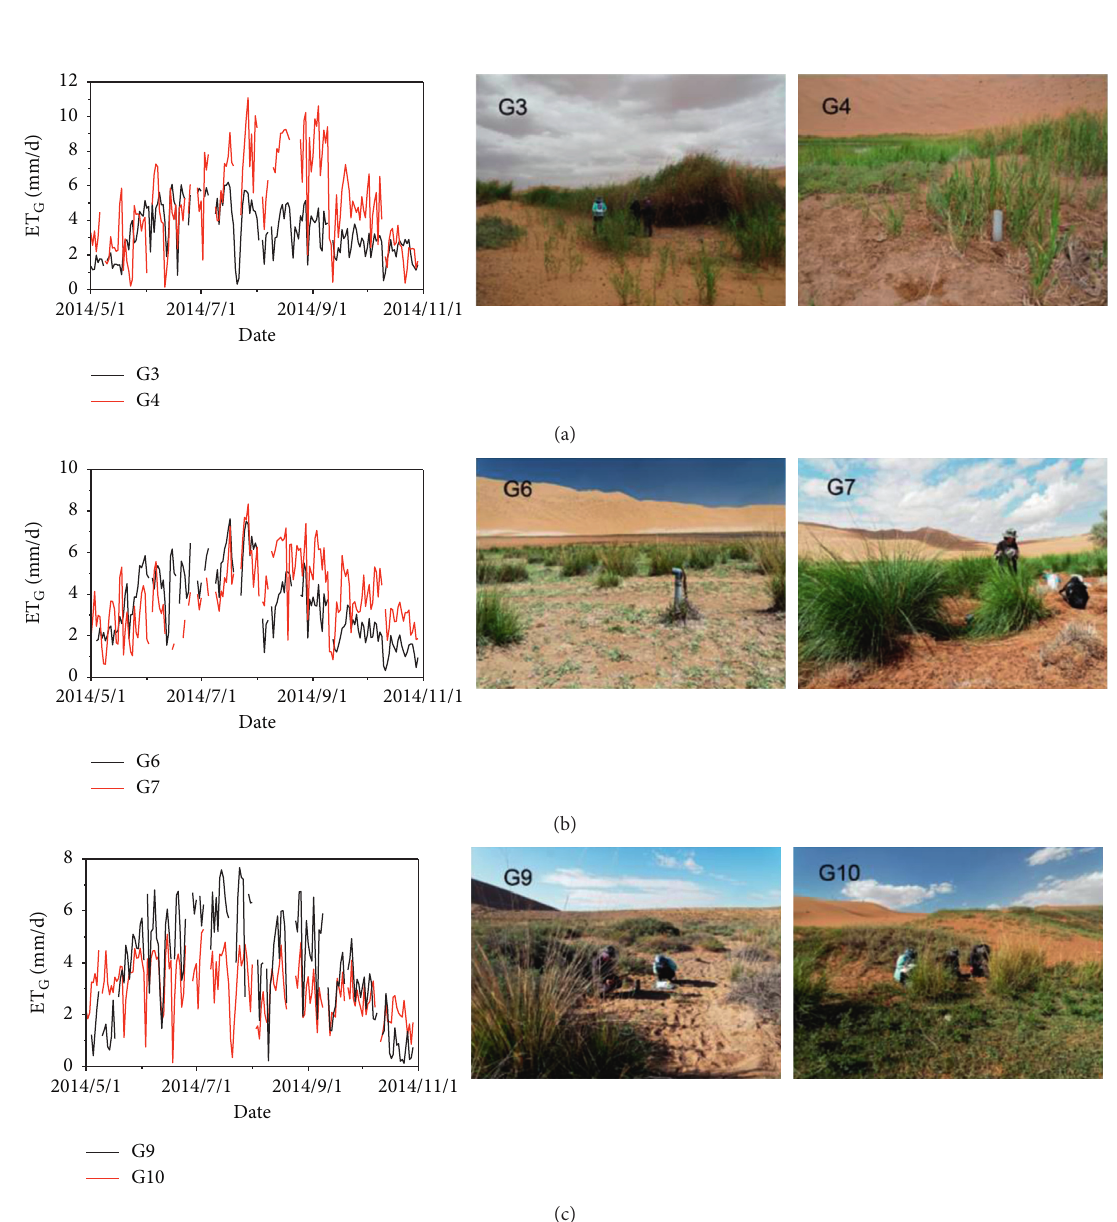
Figure 5: Estimated daily groundwater evapotranspiration (ET with different vegetation covers.